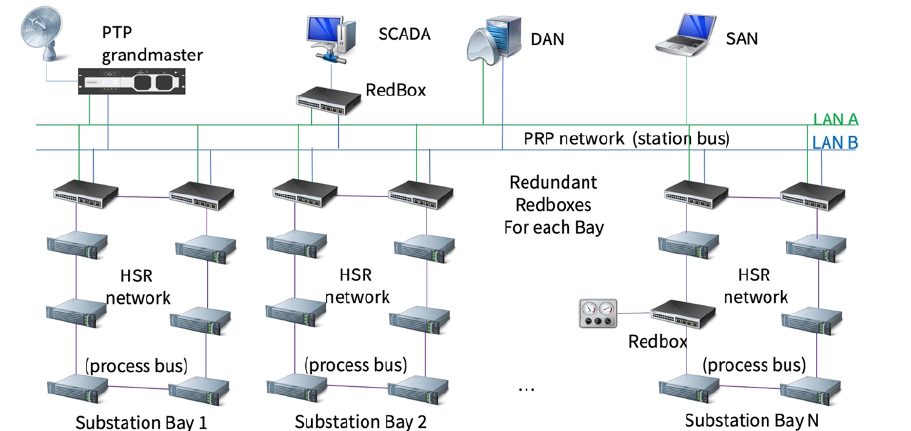
Figure 7. A redundant substation network in which the station bus is implemented with the PRP and each bay of the process bus is implemented with the HSR.